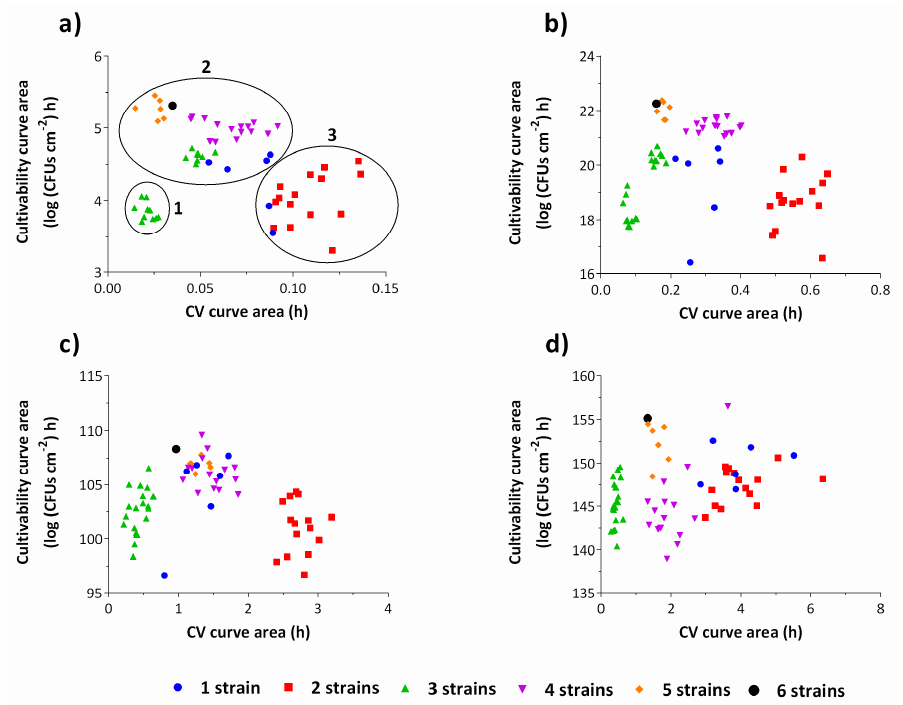
Figure 3. Cluster analysis for cultivability areas versus CV areas for each time point of the experiments: 0–2 h ( a ), 2–6 h ( b ), 6–24 h ( c ) and 24–48 h ( d ). The clustering phenomenon is more evident during